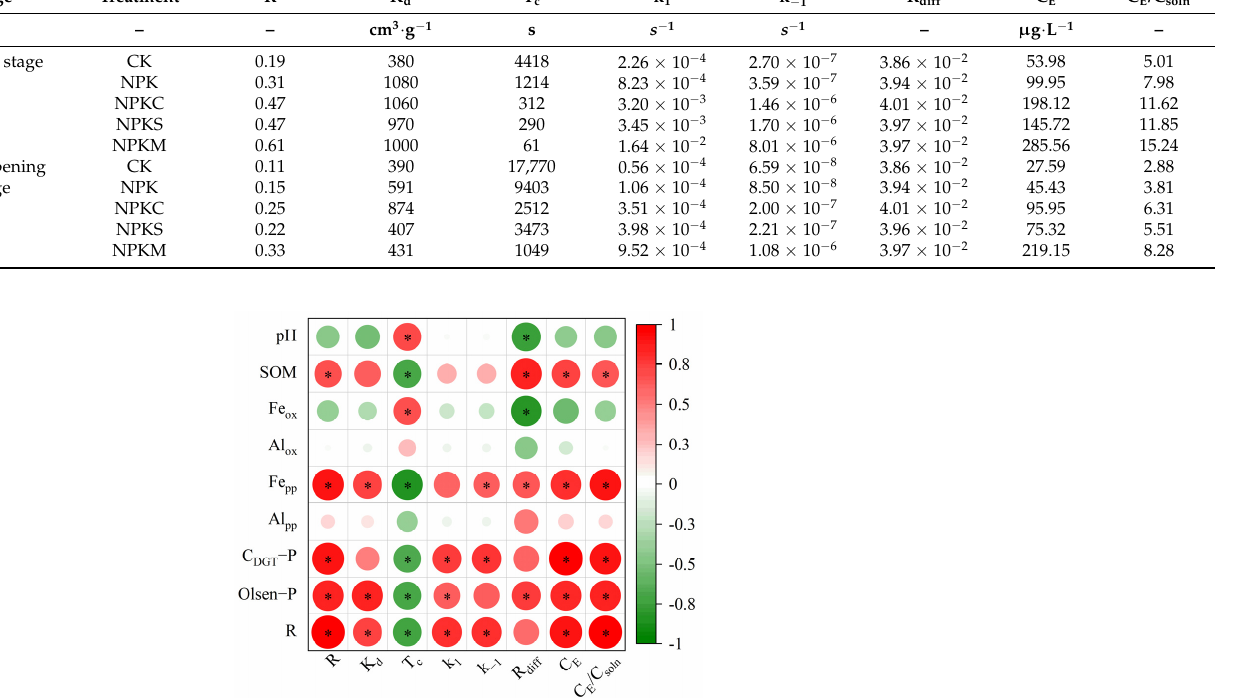
Table 5. Kinetic parameters of soil P release based on DGT and DIFS models in soils during the fifth maize season. Stage